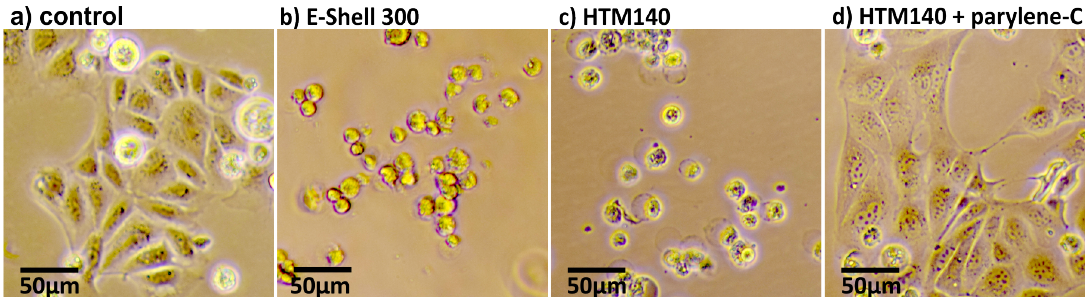
Figure 2. Cytotoxicity tests of MDCK cells exposed to 3D-printed structures built from E-Shell 300 and HTM140 resin and a 10-µm parylene-C-coated structure. The MDCK cells were grown in a multi-well plate for 24h in Glasgow Minimum Essential Medium (GMEM) supplemented with 10% fetal bovine serum and antibiotics. ( a ) Negative control. MDCK cells attached to the bottom of a well plate show normal cell proliferation. ( b , c ) MDCK cells exposed to a 3D-printed part made from E-Shell 300 or HTM140 resin, respectively. The cells did not attach to the well-plate. ( d ) MDCK cells exposed to a 3D-printed part coated with a 10- µ m parylene-C layer. The cell attached to the bottom of the well, showing similar behavior as the negative control sample.